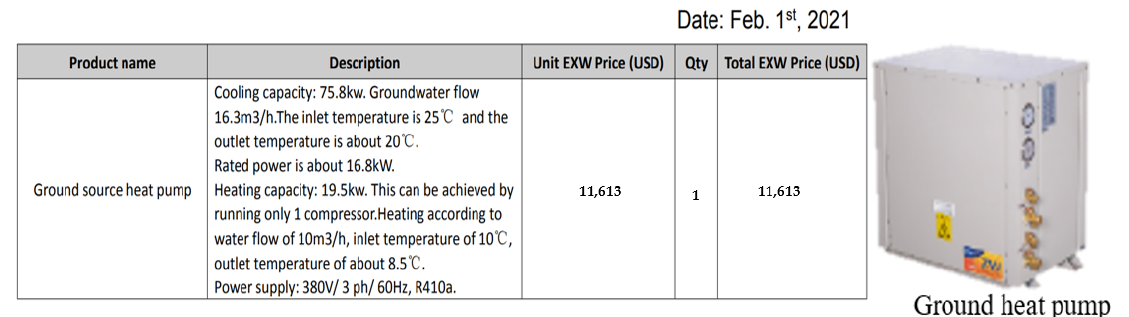
Figure A2. Ground heat pump specifications, figure, and price.